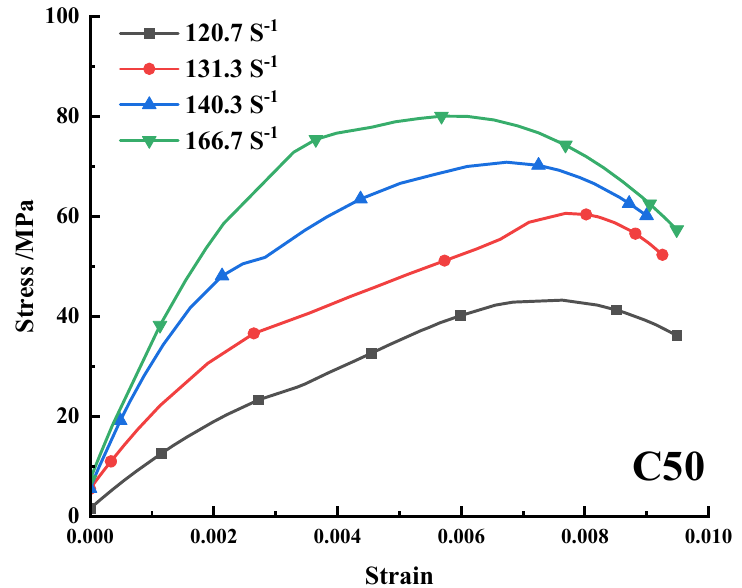
Figure 9. Stress–strain curves for HPC (C40) under various loading rates at a high temperature of 300 °C.